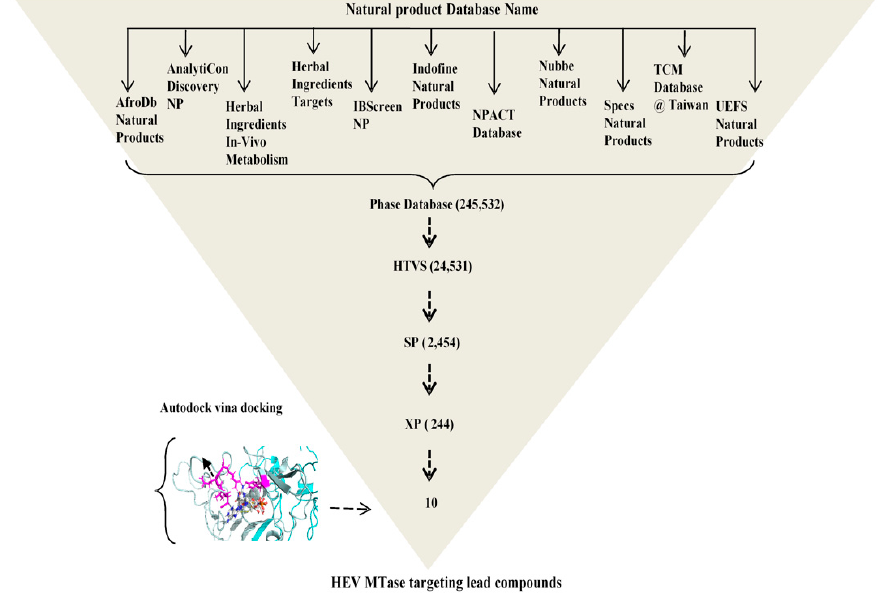
Figure 1. A flow chart depicting protocol for Virtual Screening against HEV-MTase.